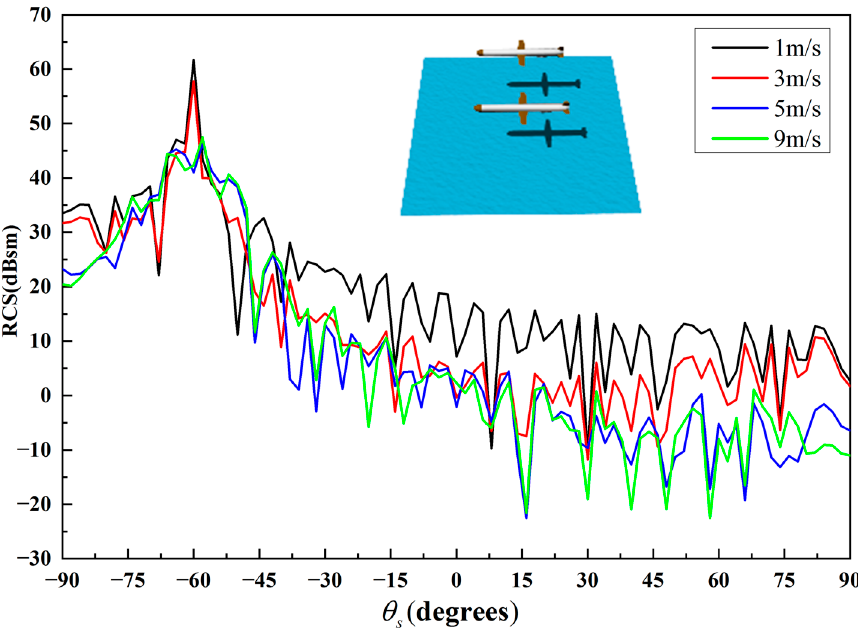
Figure 10. Bistatic RCS for HH polarization of hybrid dielectric and conductor missile-like targets with different wind speeds above the sea surface.